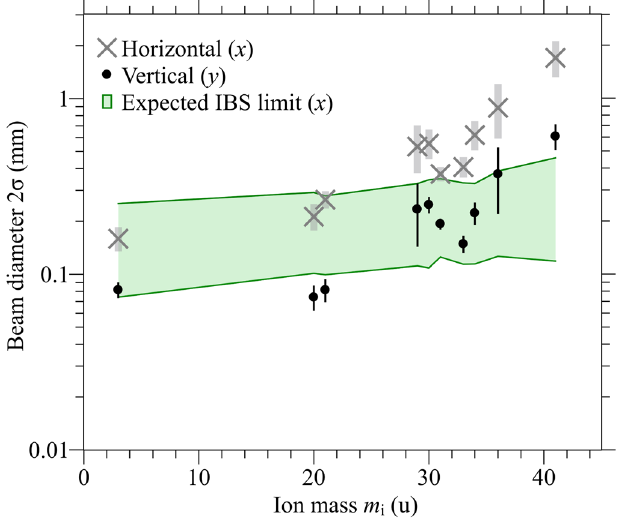
FIG. 8. Steady-state beam diameters (68% envelopes) after electron cooling. The black dots represent the data from Table II. The dashed red line indicates the expected ratio of diameters at equal horizontal and vertical divergence, given the amplitudes of the beta functions of the TSR at the Electron Target (see also Fig. 1). The blue dashed curve also accounts for the dispersion ( D x ¼ 2 . 0 m) in the Target, assuming a momentum spread δ p=p ¼ σ = β y y (see text).